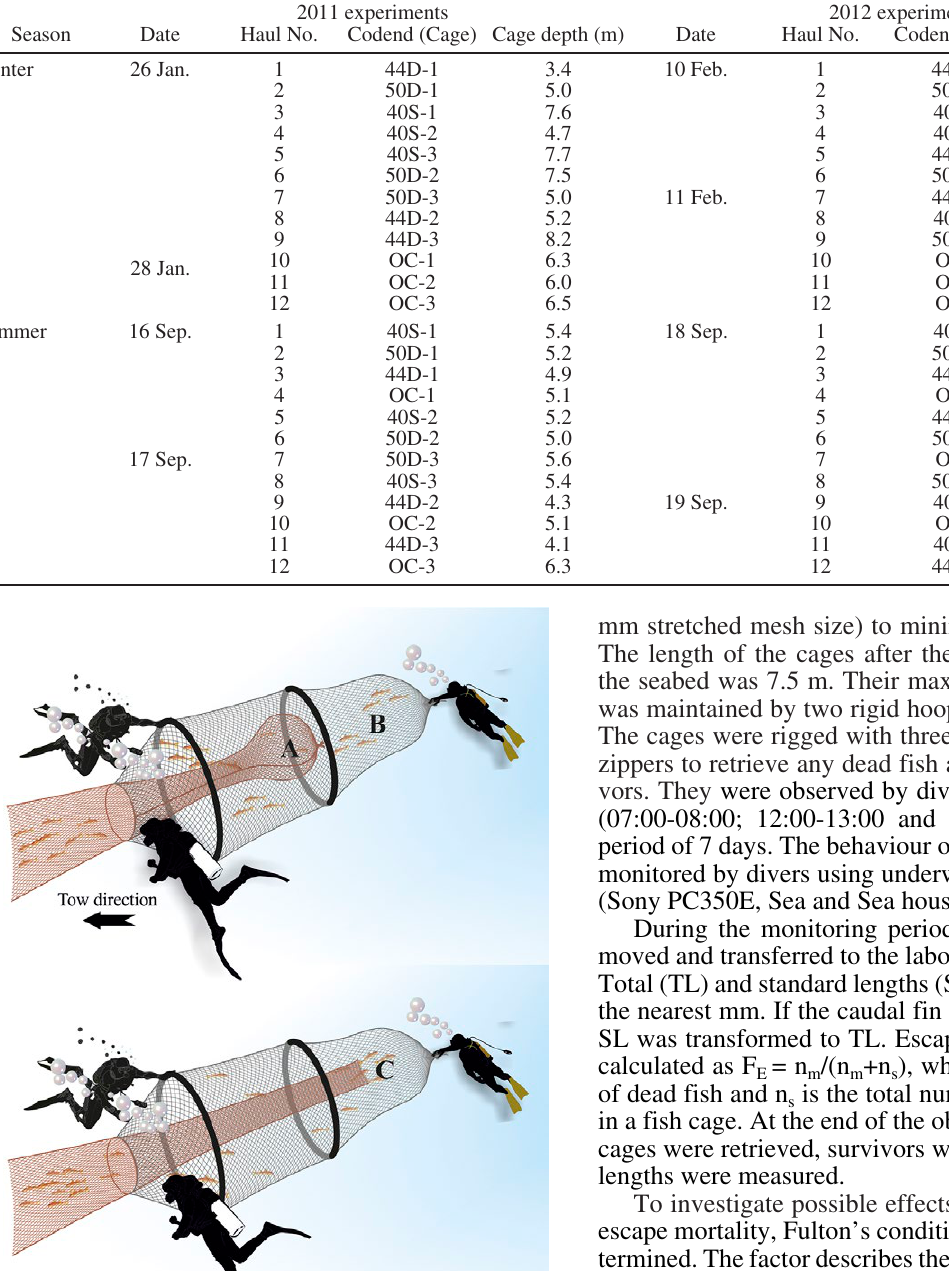
Table 1. – Details of the experimental trials (40S, 40 mm nominal square-mesh codend; 44D, 44 mm nominal diamond-mesh codend; 50D, 50 mm nominal diamond-mesh codend; OC, open codend).